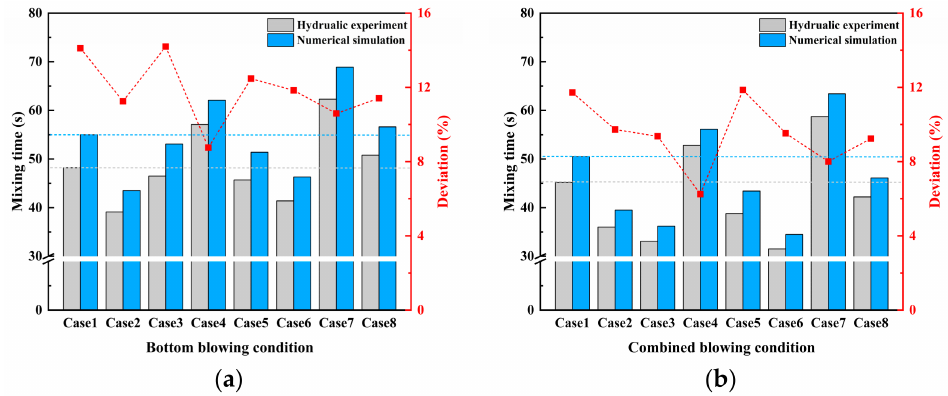
Figure 8. Mixing time of the eight cases under ( a ) bottom blowing condition and ( b ) combined blowing